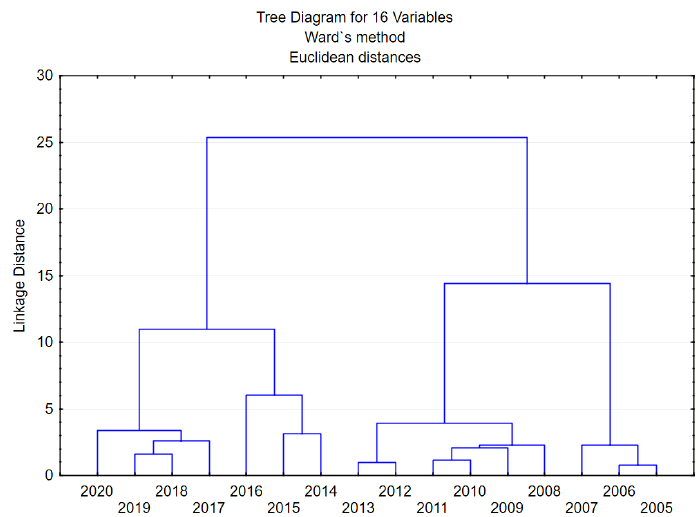
Figure 3. Dendrogram of the cluster analysis of deposit insurance development indicators in Ukraine in